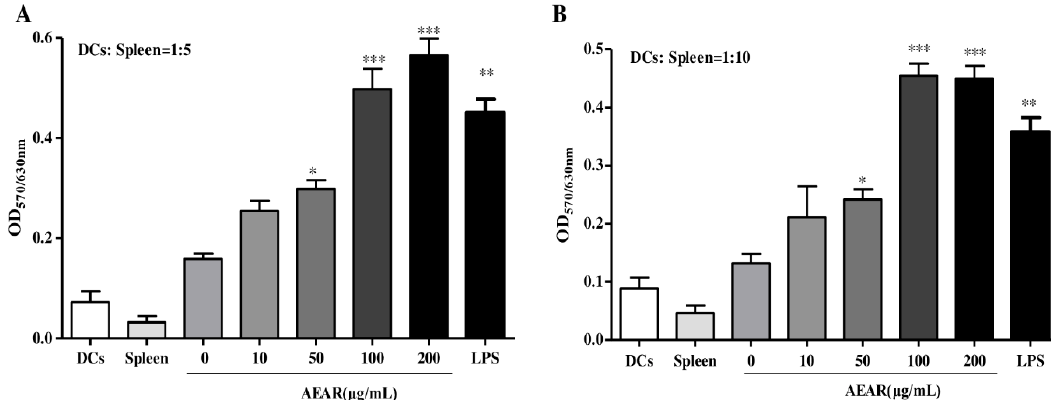
Figure 6. Allogeneic T cells’ activation by AEAR-treated DCs. Allogeneic splenocytes were co-cultured for 2 days according to the indicated ratio with DCs, which had been cultured for 12 h. MTT was added into the culture for the final 4 h treatment and T cell proliferation was then determined by ELISA. ( A ) DCs were mixed with splenocytes according to a ratio of 1:5. ( B ) DCs were mixed with splenocytes according to a ratio of 1:10. Data are expressed as mean ± SD (n = 3). * p < 0.05, ** p < 0.01, and *** p < 0.001 indicate significant di ff erences compared with the untreated DCs group, determined by one-way analysis of variance (ANOVA) and Tukey’s multiple-comparison